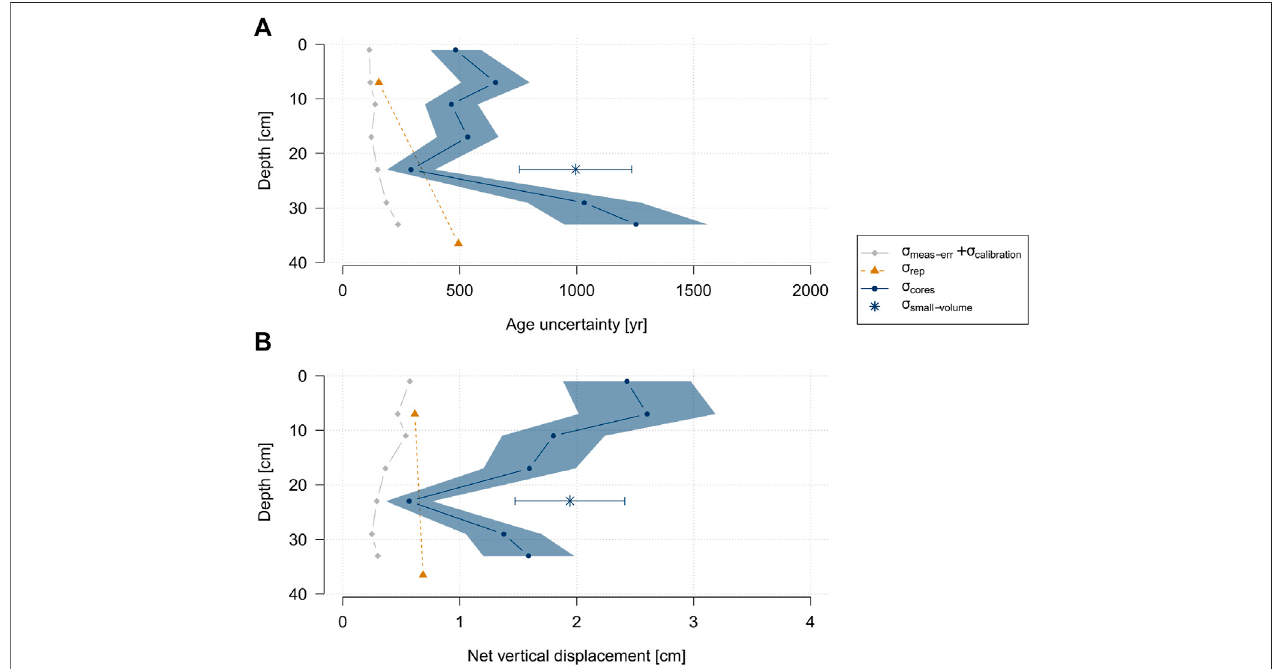
FIGURE7| Differenterrorterms affectingthereliabilityof 14 Cages derivedfrom large-volumebulk (200foraminifera) samples. Themeasurement error ( σ meas − err ) is shown combined with the uncertainty from the calendar age calibration ( σ calibration , gray). Sampling only a fi nite number of specimens ( σ rep , orange) leads to an additional uncertainty term which increases with decreasing sediment accumulation rates. The largest contribution to the overall uncertainty stems from the horizontal age- heterogeneity which is represented as the standard deviation per depth layer between the large-volume bulk samples from all sub-cores ( σ cores , blue). The small- volume bulk samples ( σ small − volume , blue star) show an even larger uncertainty due to the smaller physical volume. The variations caused by the measurement error and the fi nite sample size are subtracted from both σ cores and σ small − volume to show the true effect of the net displacement. The error terms are illustrated for (A) resulting age uncertainty and (B) the net vertical displacement by considering the change in sediment accumulation rate with depth ( Figure 4 ). The con fi dence interval and the error bar are the standard deviation of the standard deviation of the bulk samples, but in (B) not accounting for the uncertainty in the sediment accumulation